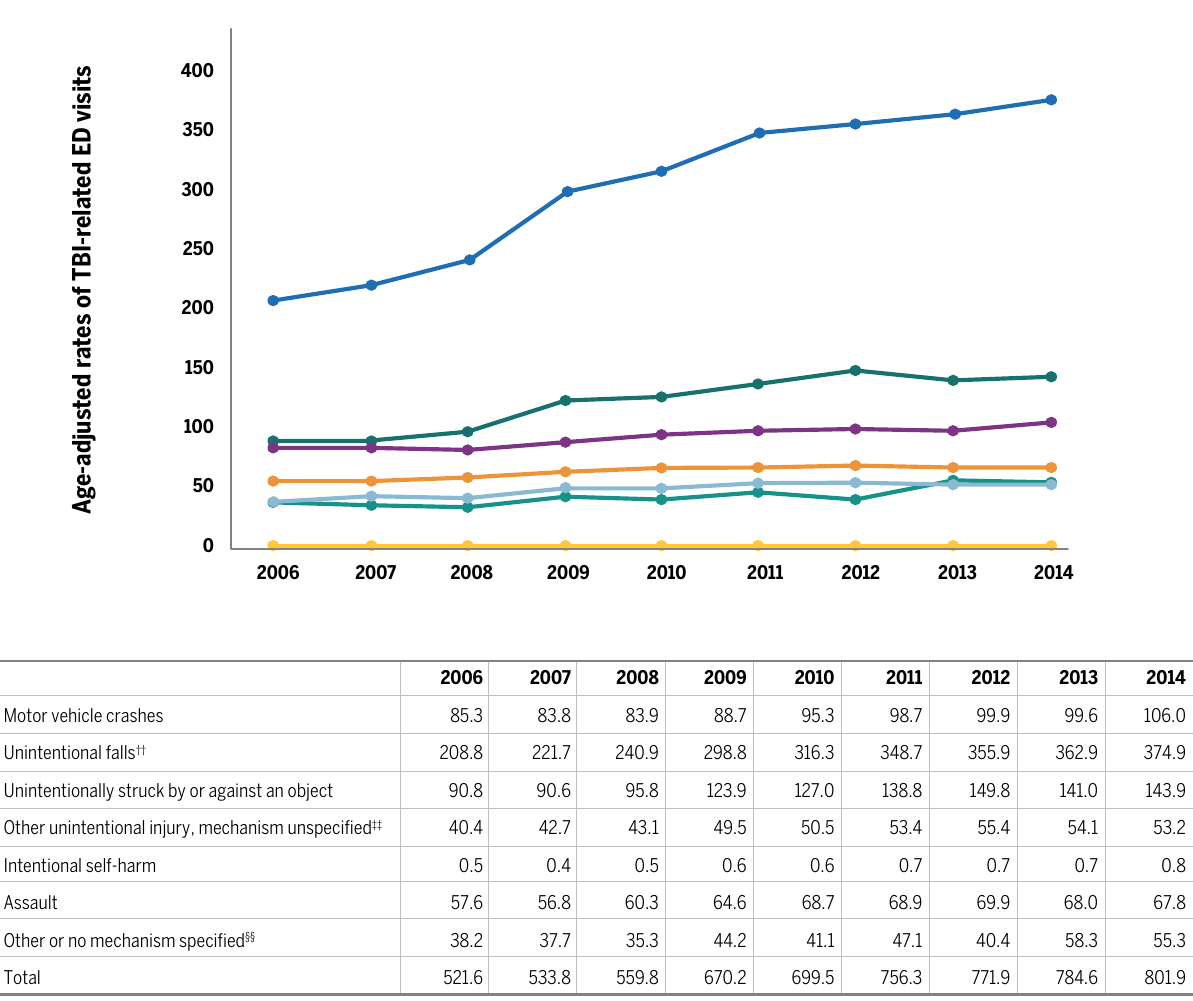
FIGURE 2A: ESTIMATED AGE-ADJUSTED RATES ¶ , PER 100,000 POPULATION, OF TRAUMATIC BRAIN INJURY– RELATED EMERGENCY DEPARTMENT VISITS, BY YEAR AND MECHANISM OF INJURY,